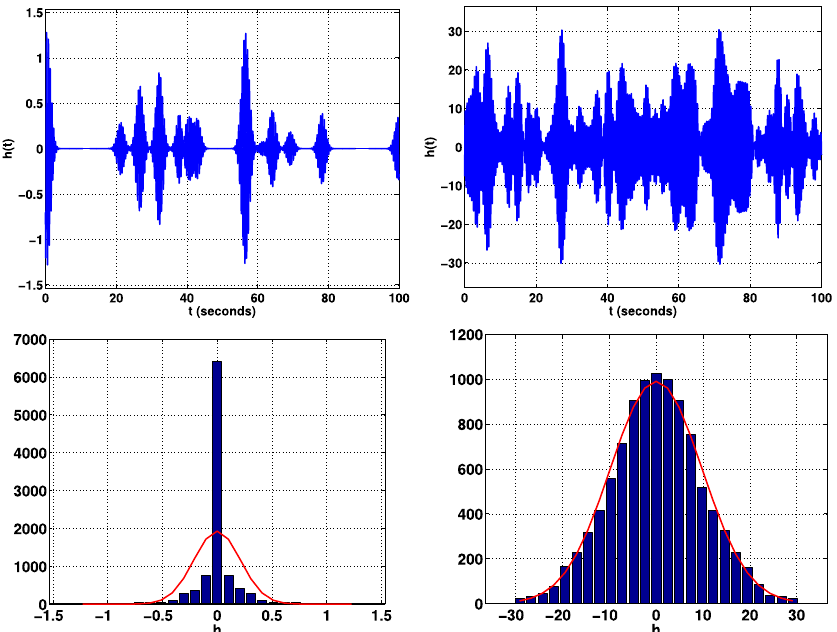
Fig. 57 Simulated toy-model signals and histograms for different duty cycles. The left two panels cor- respond to 1 burst every 10 s (on average); the right two panels correspond to 100 bursts every second (on average). The red curves in the bottom two panels show the best-fit Gaussian distributions to the data. Similar to Fig. 1 from Thrane